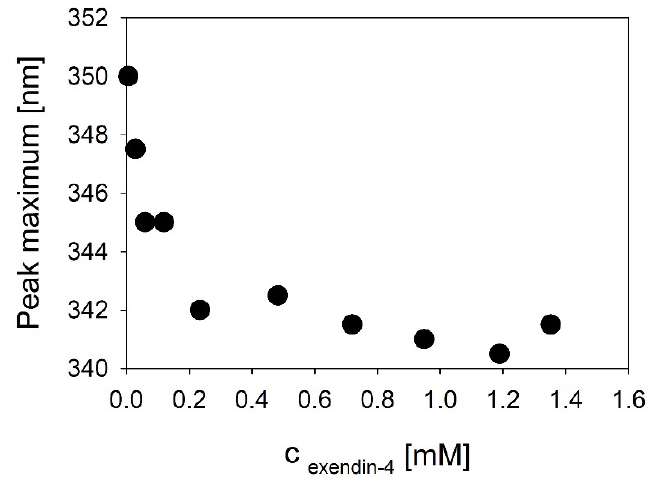
Figure 5. Spectral signature changes of the hydrophobic moiety accompanying self-assembly of